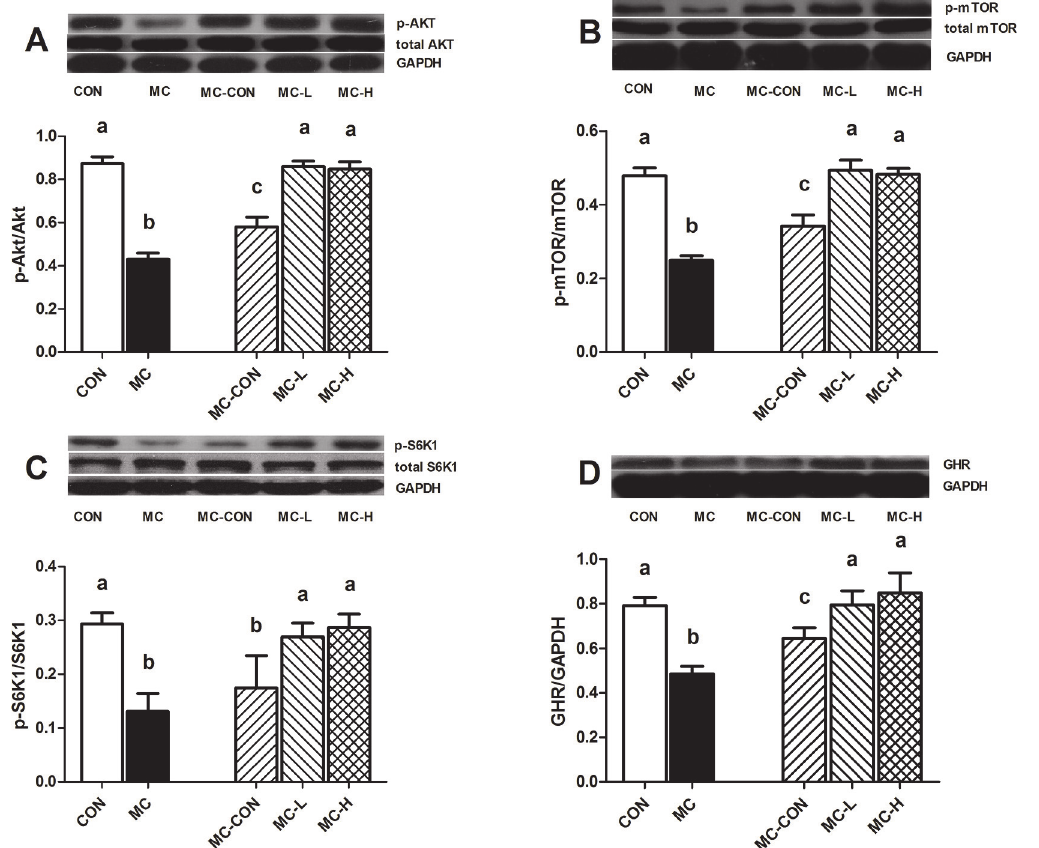
Fig 5. Phosphorylation of mTOR-related Signaling Effectors in the Gastrocnemius. Akt phosphorylation at Ser473 and total Akt (A), mTOR phosphorylation at Ser2448 and total mTOR (B), p70-S6K1 phosphorylation at Thr389 and total p70-S6K1 (C), and GHR expression levels in the liver (D) were assessed by western blot. The band densities were quantified by the ImageJ software. Data are presented as means ± standard deviation (SD). Different letters indicate a significant difference (p < 0.05). Akt, protein kinase B; GHR, growth hormone receptor; mTOR, mammalian target of rapamycin; p70-S6K1, ribosomal protein S6 kinase